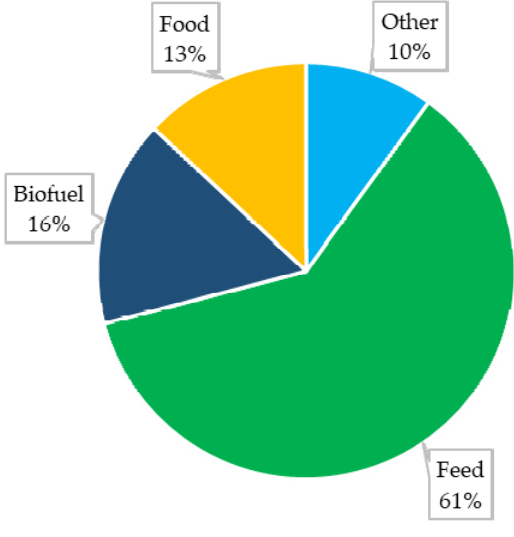
Figure 1. Global use of maize [2].